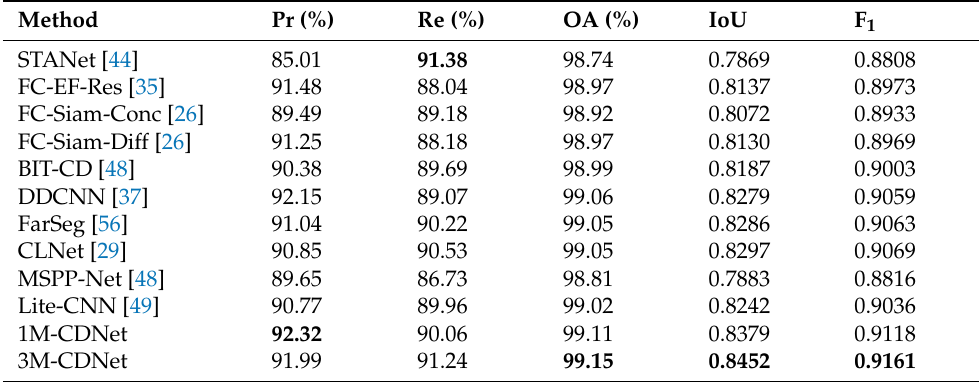
Table 5. Comparison of results on the LEVIR-CD